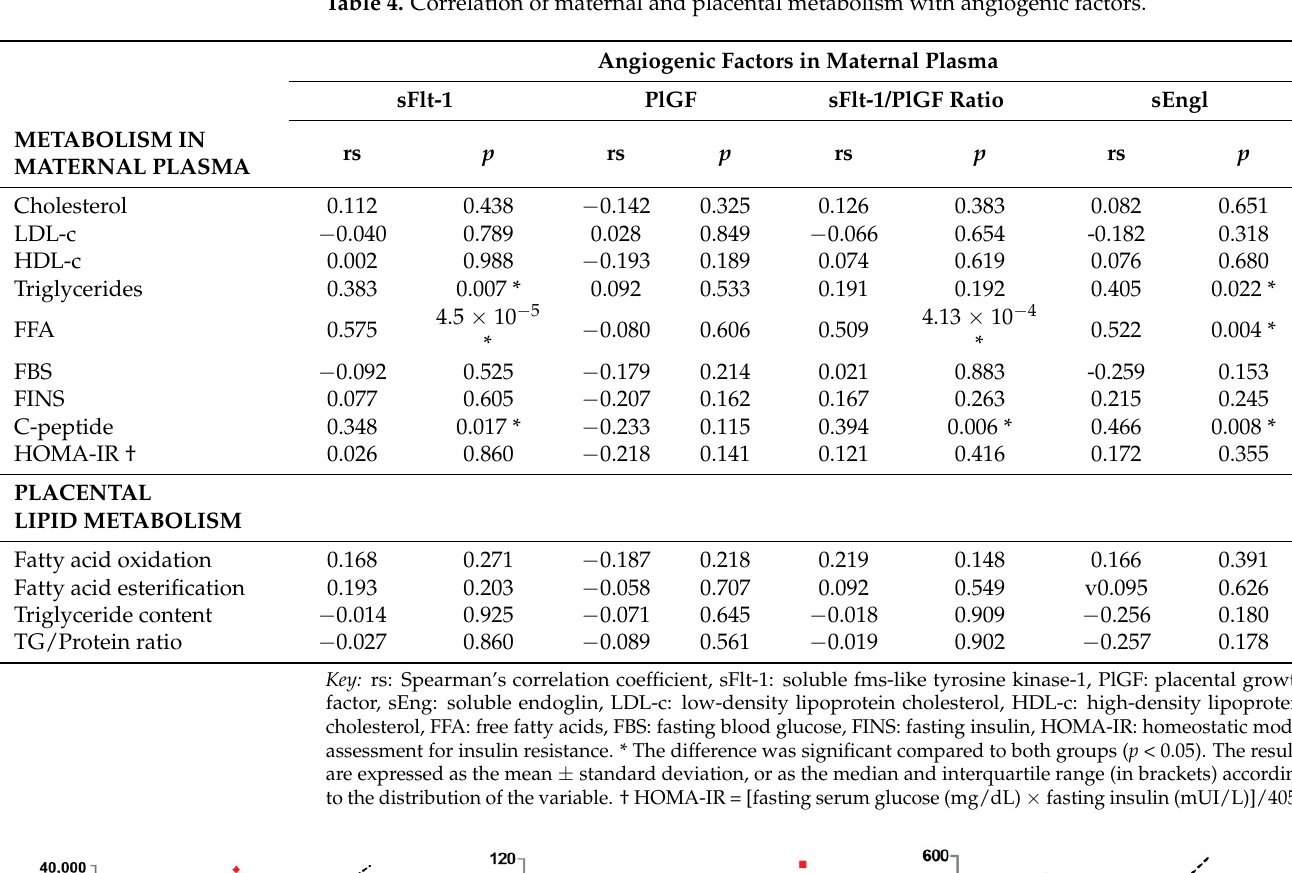
Table 4. Correlation of maternal and placental metabolism with angiogenic factors.